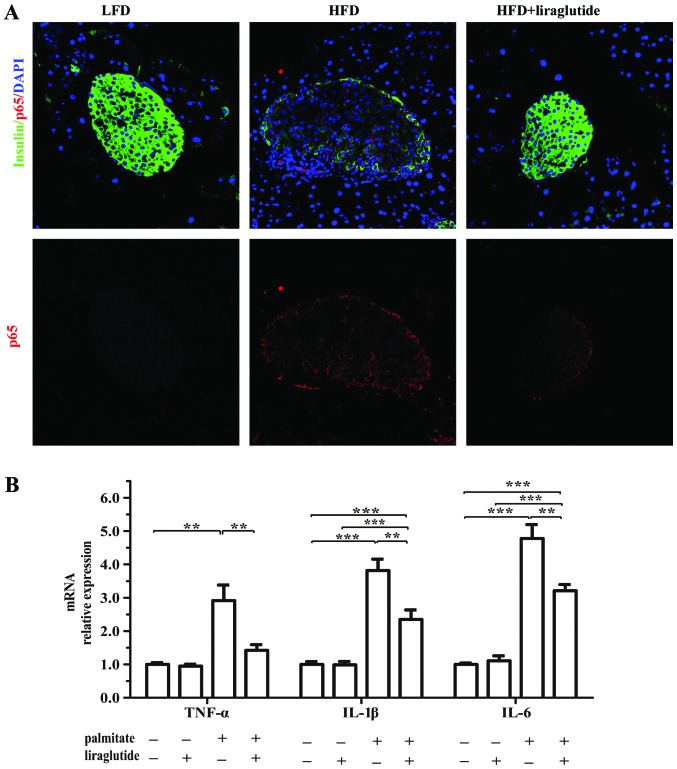
Glucagon-like peptide-1 receptor (GLP-1R) signaling suppresses islet inflammation. (A) Representative images of staining for insulin (green) and p65 (red) in vivo. n=6–7 mice. (B) Following pre-incubation with 100 nmol/l liraglutide for 2 h, followed by exposure to 0.5 mmol/l palmitate for 48 h, tumor necrosis factor-α (TNF-α), interleukin (IL)-1β and IL-6 mRNA levels were detected by qPCR. n=3 separate isolated islet preparations. **p<0.01; ***p<0.001.